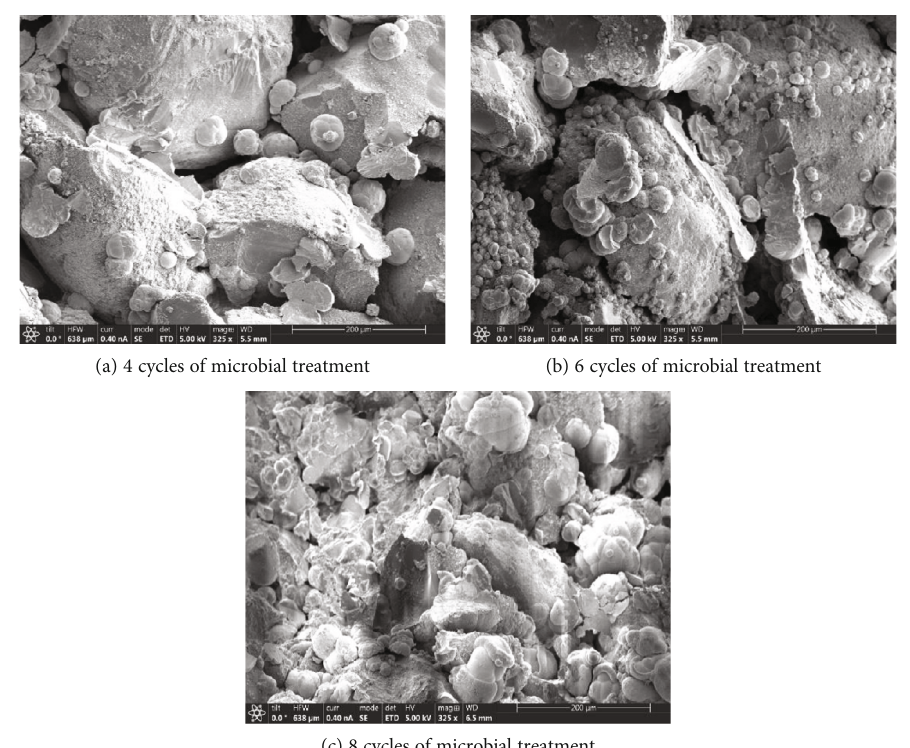
Figure 7: Distribution of CaCO within pore space of 60/80 mesh Ottawa sand with biotreated 4, 6, and 8 cycles. 3